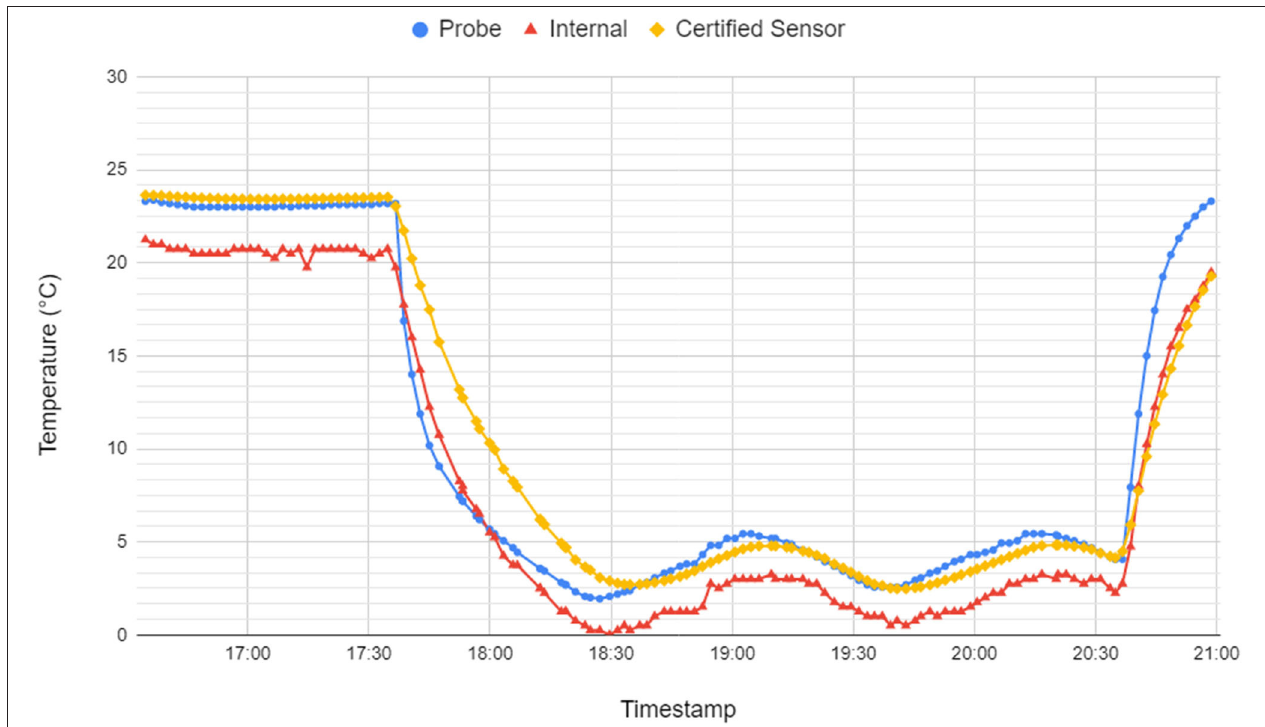
FIGURE 10 | A comparison of temperature sensor readings for two versions of the IoT monitor (one using an on-board sensor and the other with the DS18B20 probe attached) against certified temperature logger measurements.